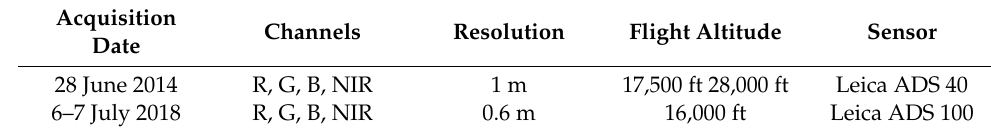
Table 1. NAIP imagery characteristics, acquired through USGS EE.